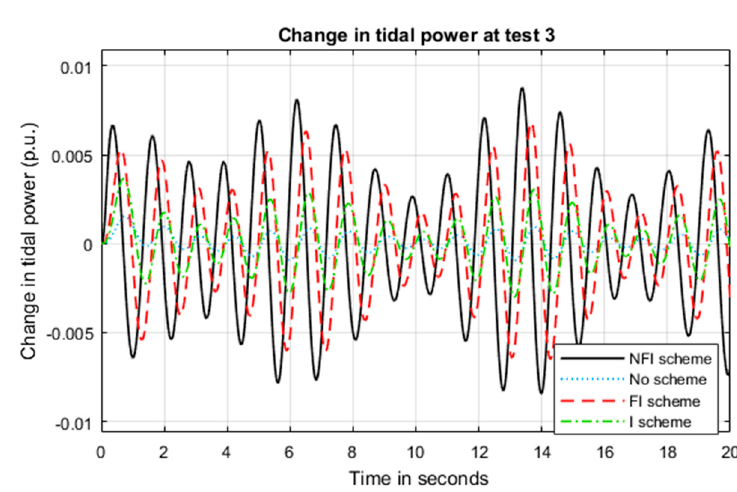
Figure 21. Change in tidal power in test 3.